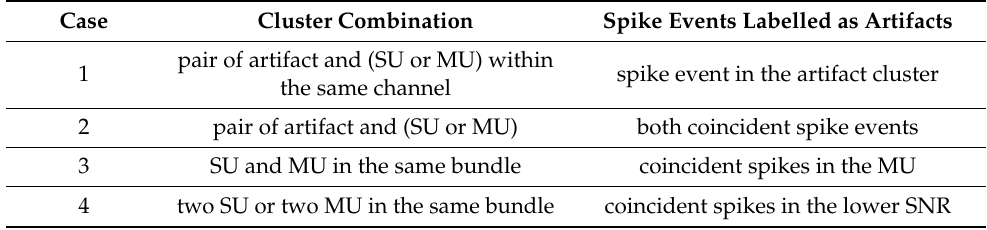
Table 2. Criteria for labelling two coincident spikes events in Part II. Case Cluster